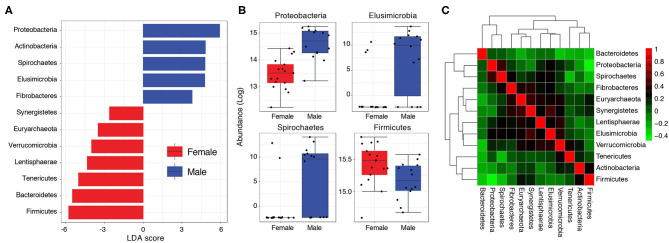
(A) Bar graph showing LDA scores of significant features (phyla) characterizing Pakistani male and female gut samples. (B) Boxplots comparing phyla with significant differential abundance in males and females (Wilcoxon rank-sum test, FDR < 0.05). (C) A heat-map visualizing how phyla abundances in the Pakistani gut correlate to each other (Kendall's τ).